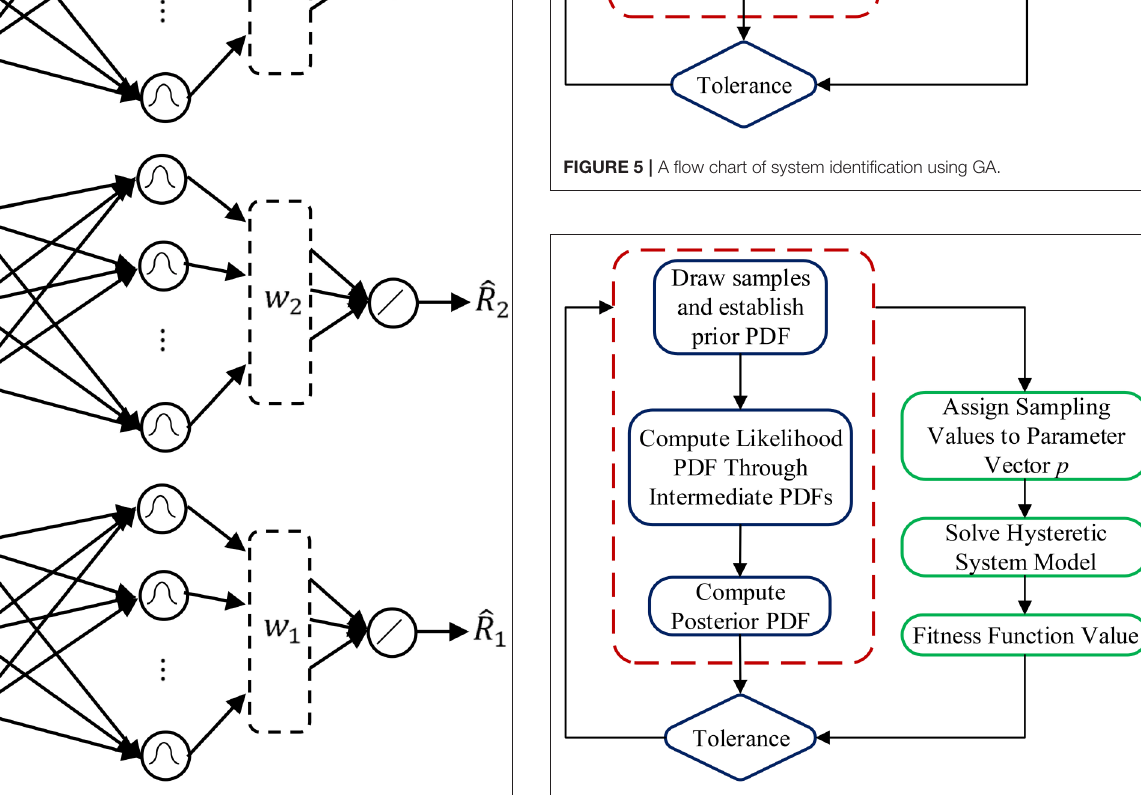
FIGURE 4 | IPV for structural system modeling.